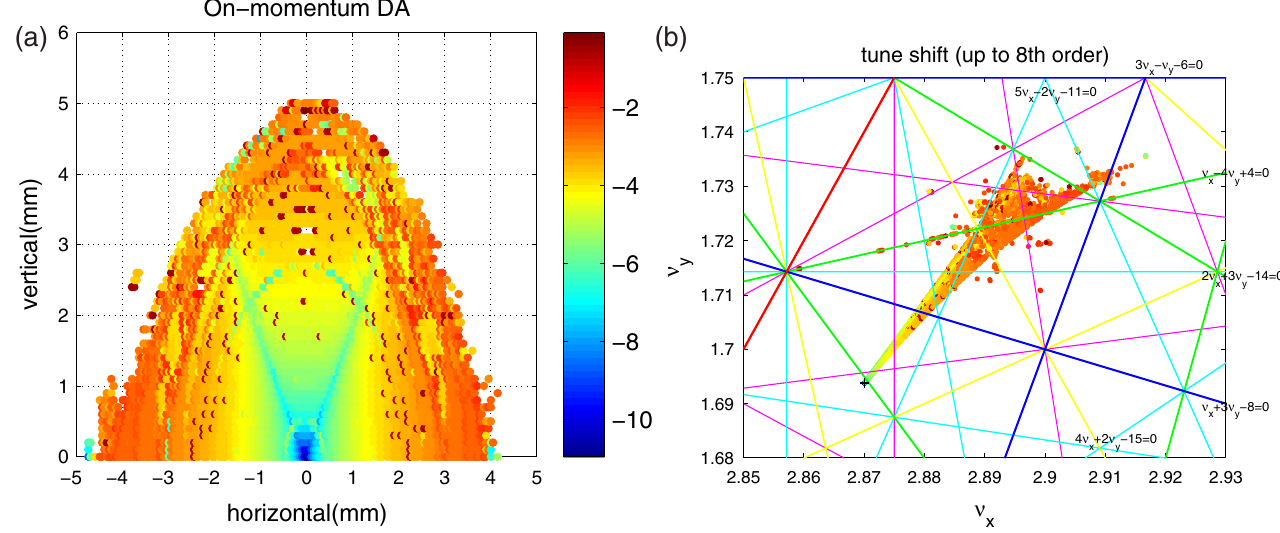
FIG. 4. (Color) (a) On-momentum DA and (b) the frequency map at the IP. Subfigure (a) presents the tune diffusion at the surface of the IP, while subfigure (b) presents the tune spread in the tune diagram. The point in the cooler color indicates that it has less tune diffusion, which is more stable. The dynamics is affected by the node between 5th-order resonance (cid:7) x (cid:1) 4 (cid:7) y þ 4 ¼ 0 , 6th-order resonance 4 (cid:7) x þ 2 (cid:7) y (cid:1) 15 ¼ 0 , and 7th-order resonance 5 (cid:7) x (cid:1) 2 (cid:7) y (cid:1) 11 ¼ 0 . When the magnet errors further excite the 4th-order and 5th-order resonances, the DA would shrink to 2